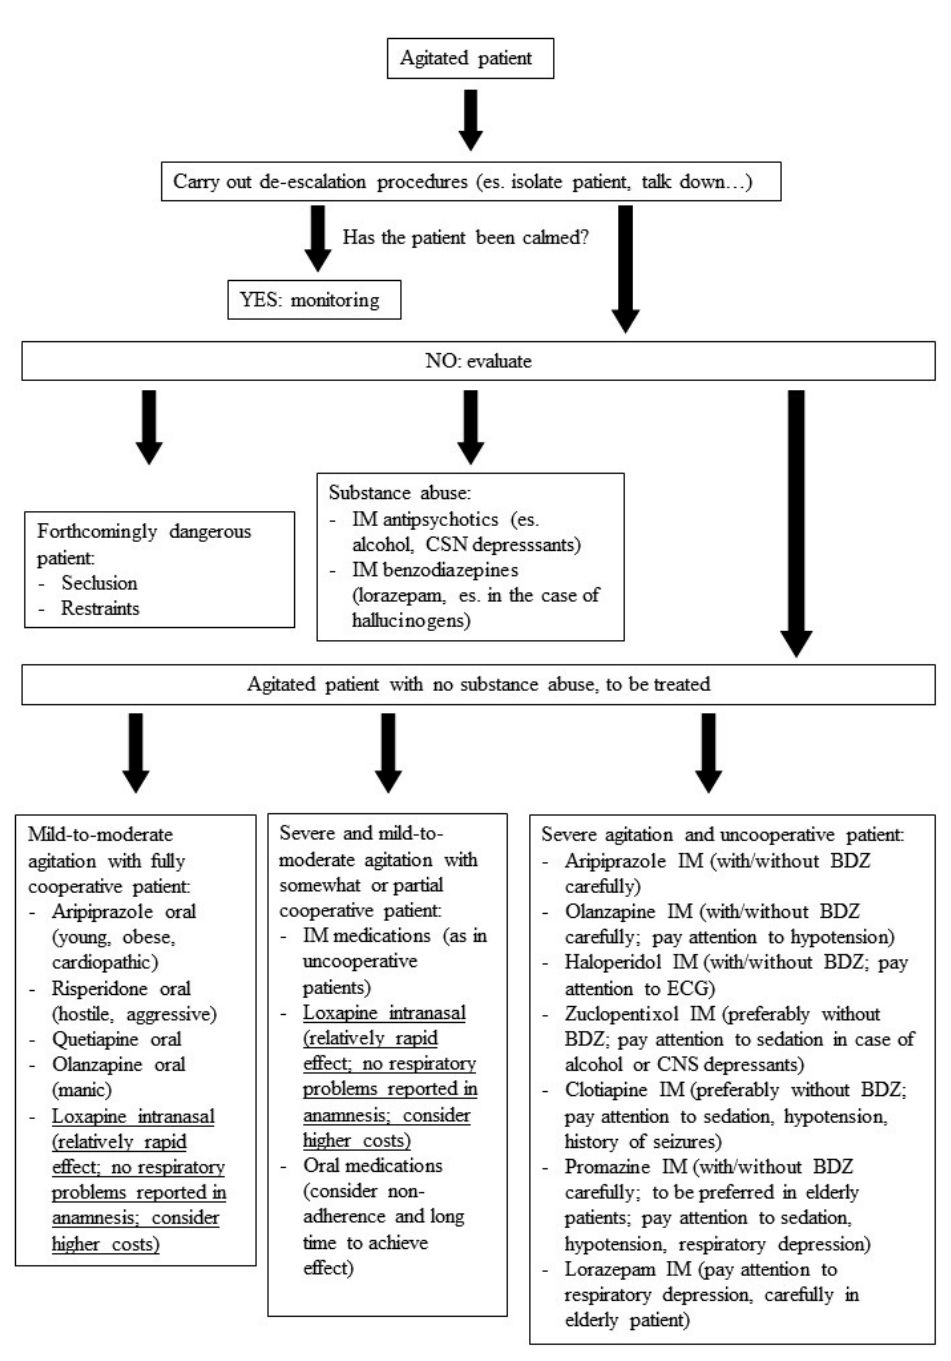
Figure 1. Management of acute agitation: the suggested position of intranasal FGA loxapine (adapted and modified from Schleifer [70].